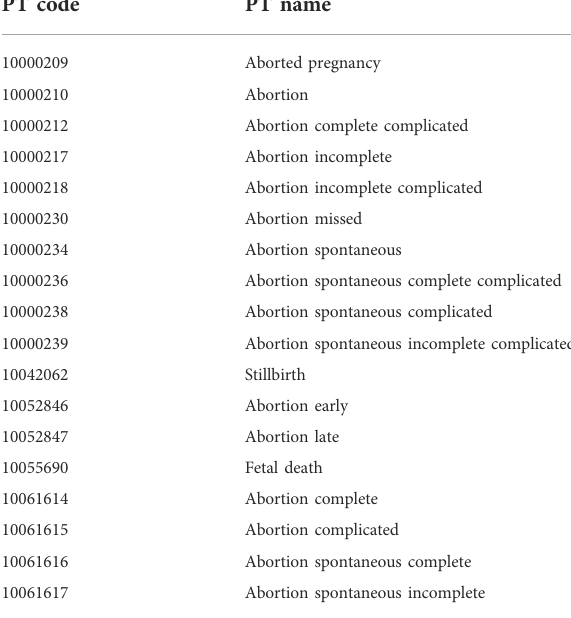
TABLE 1 De fi nitions of pregnancy loss in this study. TABLE 2 Adverse eventsrelated “ Termination ofpregnancy andrisk of abortion (SMQ) ”